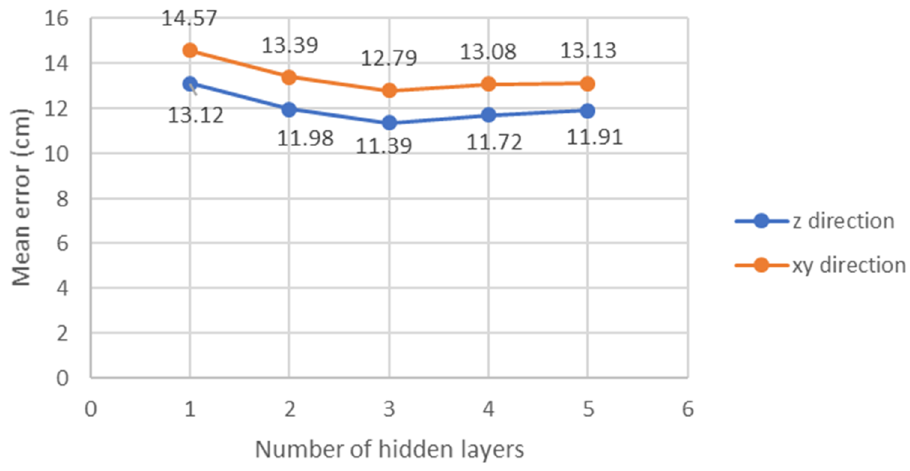
Figure 13. Mean error of the one stage NN using a different number of hidden layers.